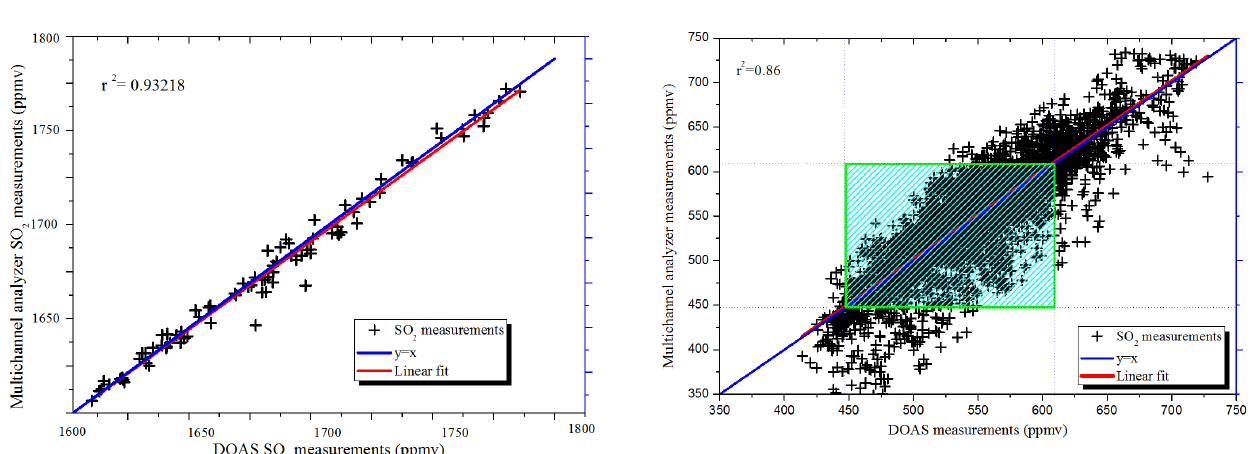
Figure 14. Correlation between SO 2 concentrations measured with the DOAS analyzer and the multichannel analyzer on 6 July 2012 at the Fuxin steel plant. Outliers during the blowback period are removed.